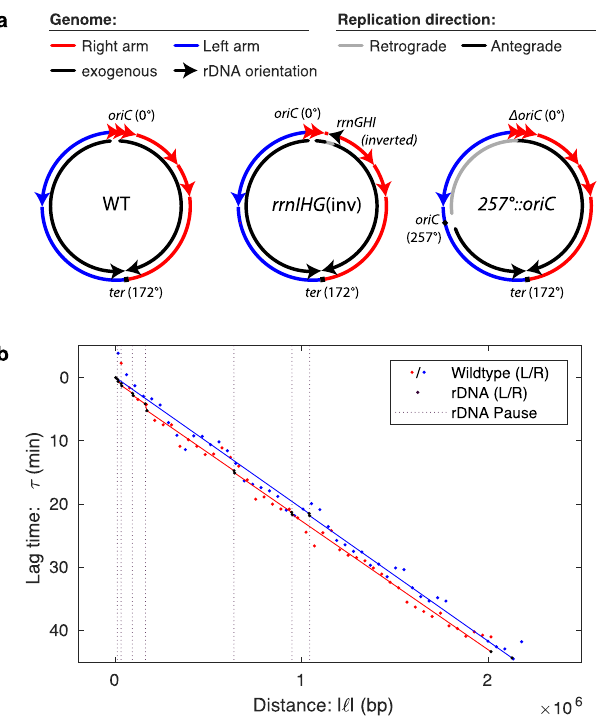
segments represent replication in the retrograde direction. b Lag timein wild-type cells. Replication on the right arm (red) isdelayed relative to the left arm (blue) by multipleendogenousco-directionalrDNAloci. c Head-oncon fl ictsleadtopausing. The rrnIHG genesareinvertedsothattranscriptionoftherDNAlocusisinthehead- ondirection.Alongerlag-timepauseisobservedatintermediategrowthrates(CA, purple) than slow growth (minimal, red). Fork velocities elsewhere are roughly consistent. d Retrograde fork motion is slow. The retrograde fork motion in R